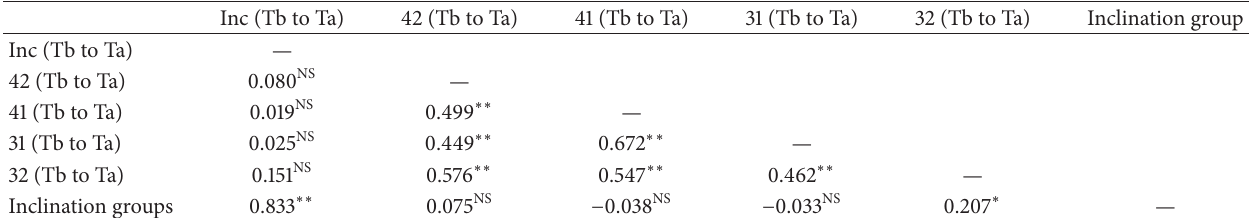
Table 4: Correlations among different factors (Pearson correlation coefficients and significance